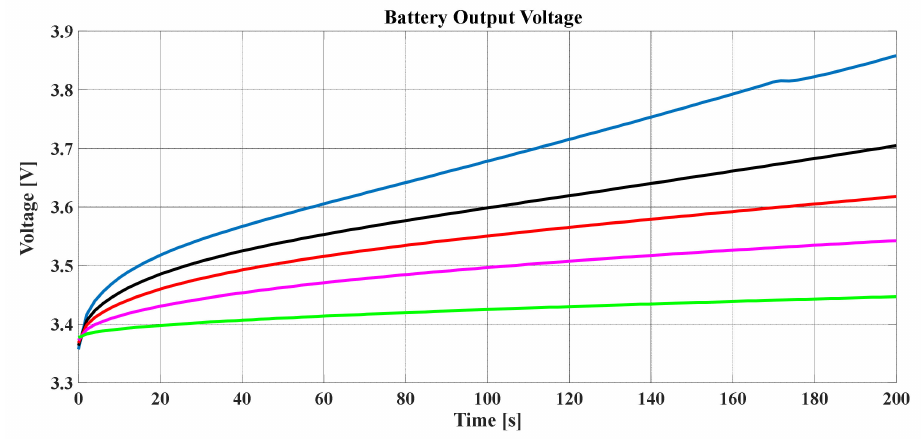
Figure 15. The charging performance of the battery with respect to the discharging time based on the